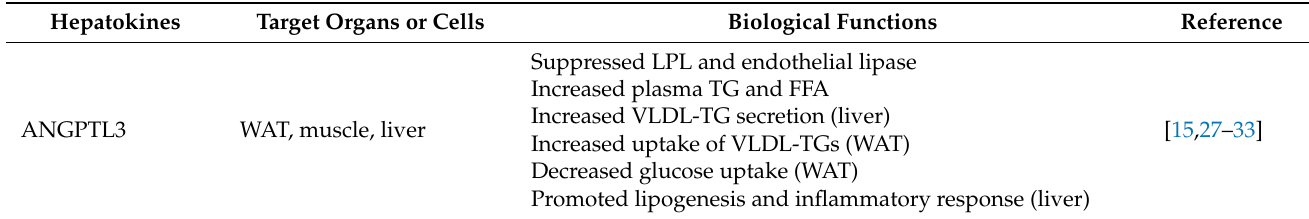
Table 1. Target organs or cells of hepatokines and their biological functions.